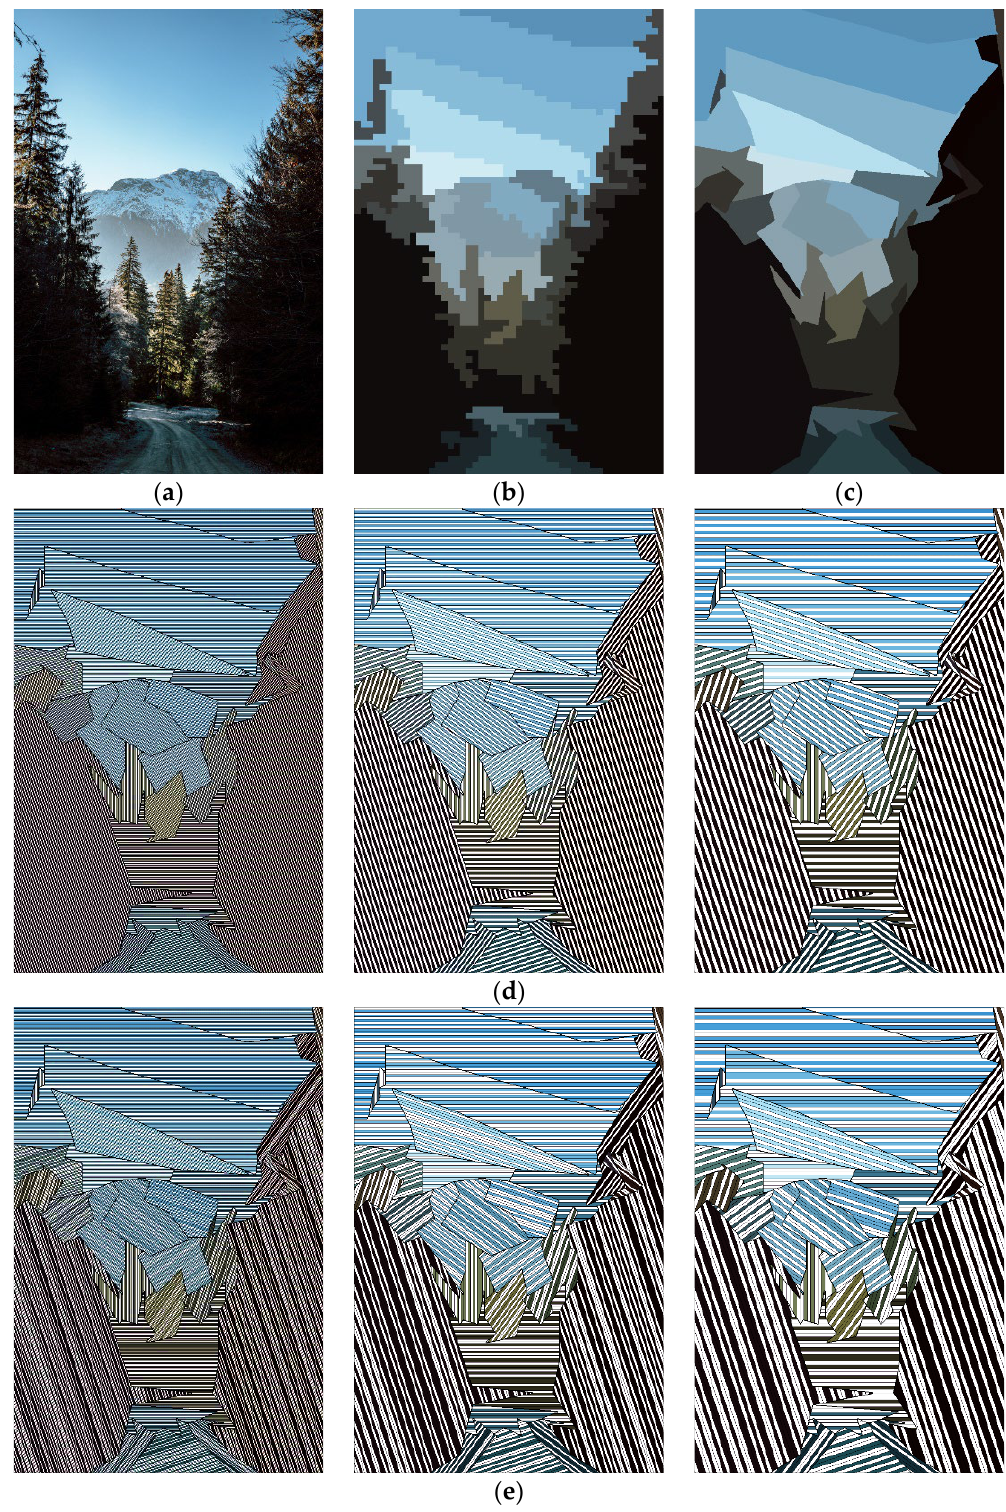
Figure 15. Experimental result 3. ( a ) An original image by Andrei Tanase [30]. ( b ) The result of image segmentation of ( a ). ( c ) The result of polygon approximation of each region of ( b ). ( d ) Three Futurism-like images created by ( a ) with the stripe widths of 3, 6, and 9 pixels, respectively. ( e ) Three stego-images created from ( a ) by embedding the message “Actions speak louder than words.” with the secret key “Action” and the stripe widths of 3, 6, and 9 pixels, respectively.